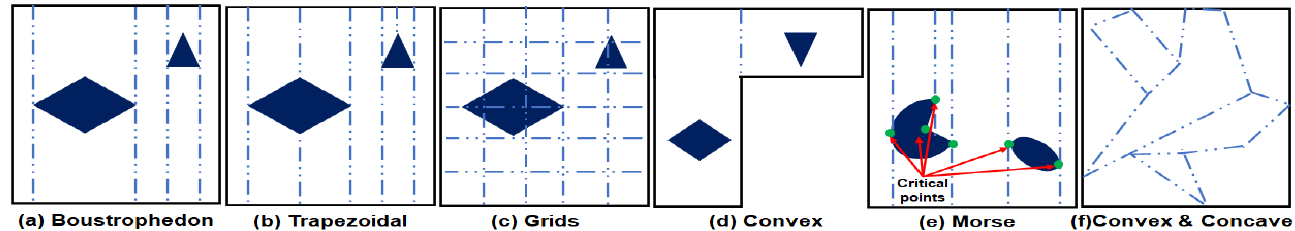
Figure 2. Most widely used AOI decomposition approaches for the coverage path planning.